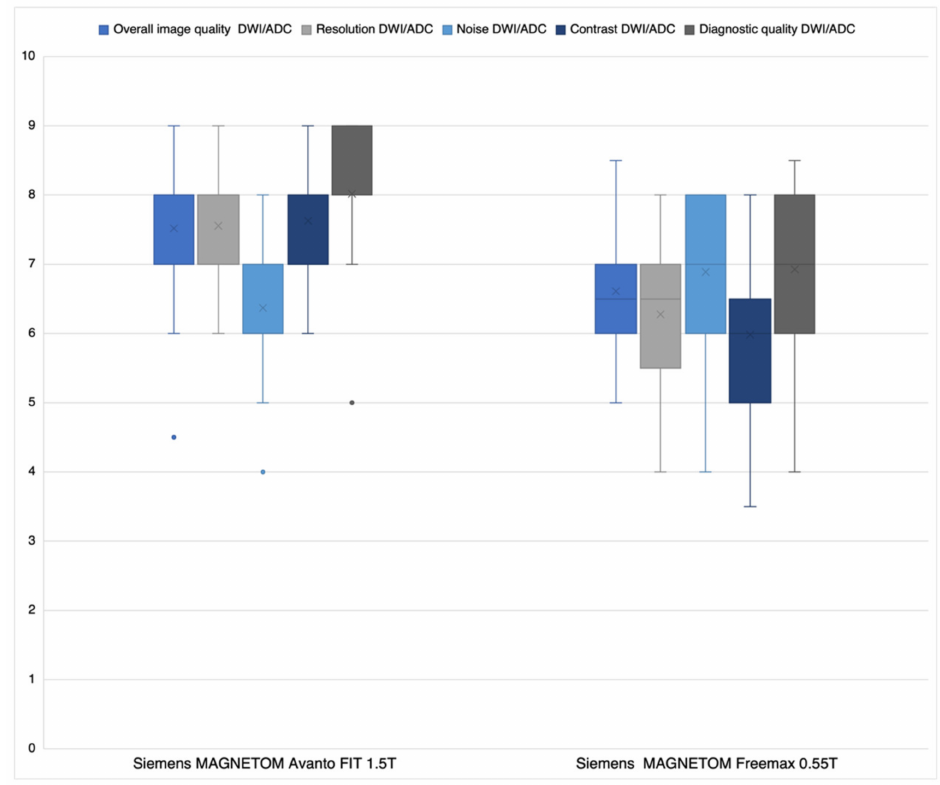
Figure 3. Average Likert-scoring reader 1 and 2 DWI/ADC sequences.